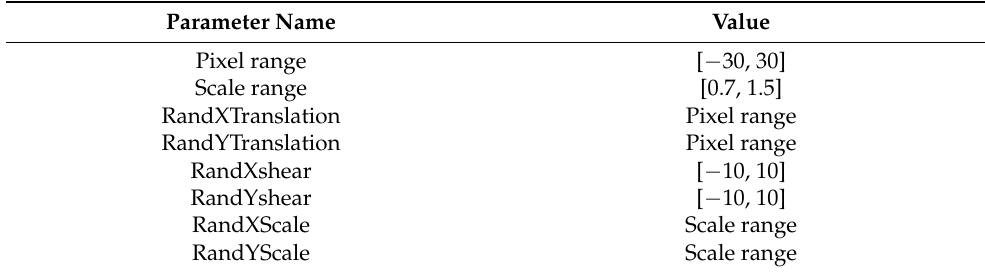
Table 3. Dataset augmentation